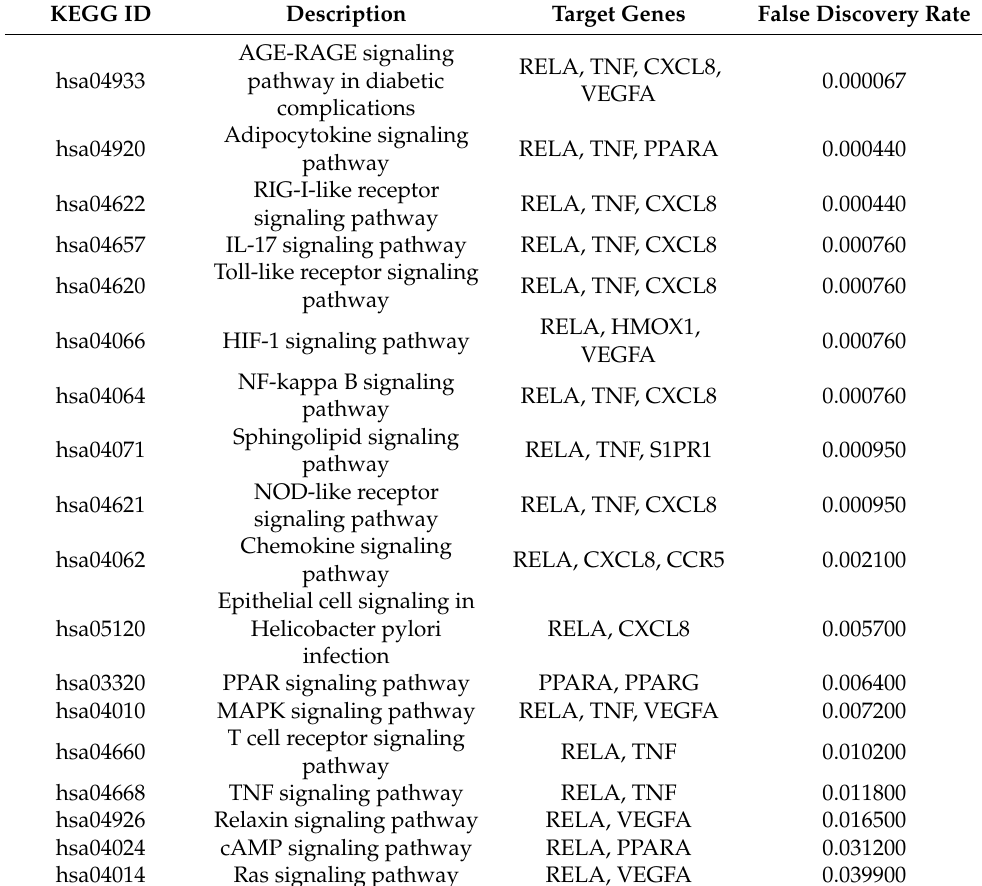
Table 3. Targets in 18 signaling pathways with enrichment related to COVID-19.